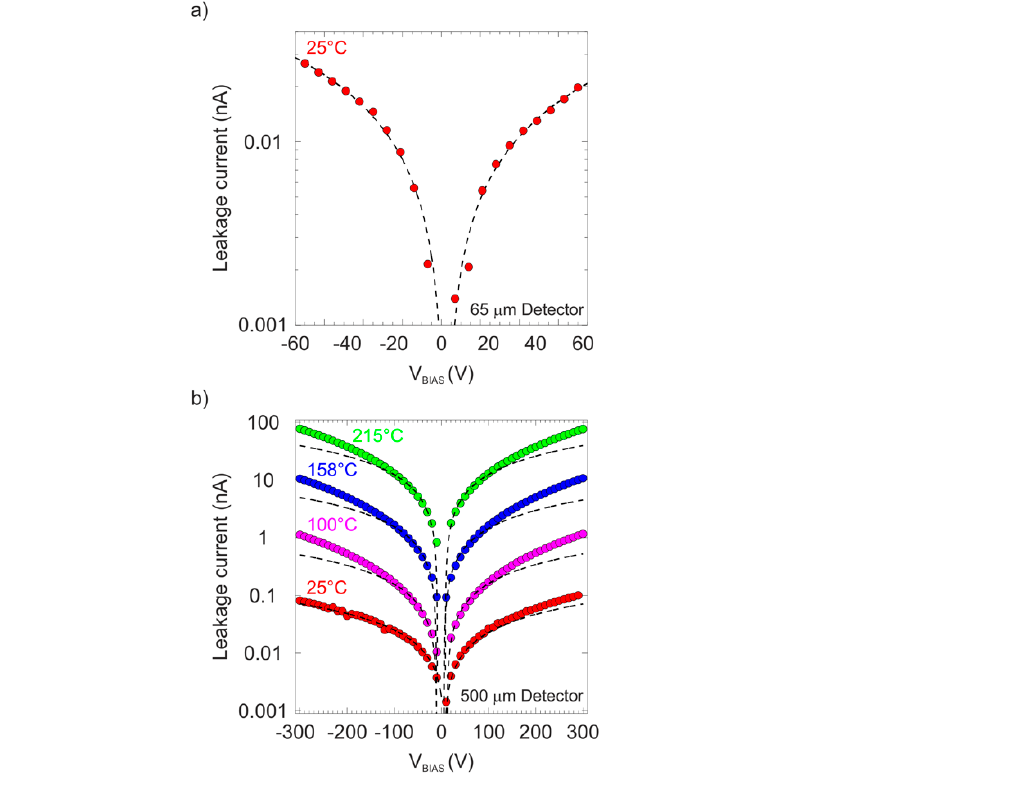
Figure 5. ( a ) Leakage current vs. applied bias for the 65 μ m detector at room temperature; ( b ) Leakage current vs. applied bias for the 500 μ m detector at four different temperatures.